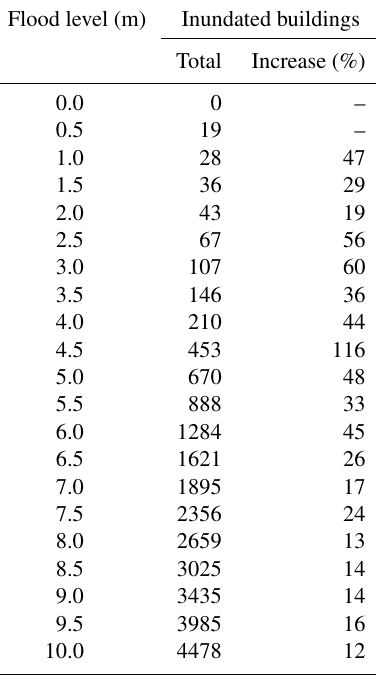
Table 1. The number of inundated buildings within the Lisbon ur- ban cluster at hypothetical flood levels between 0 and 10